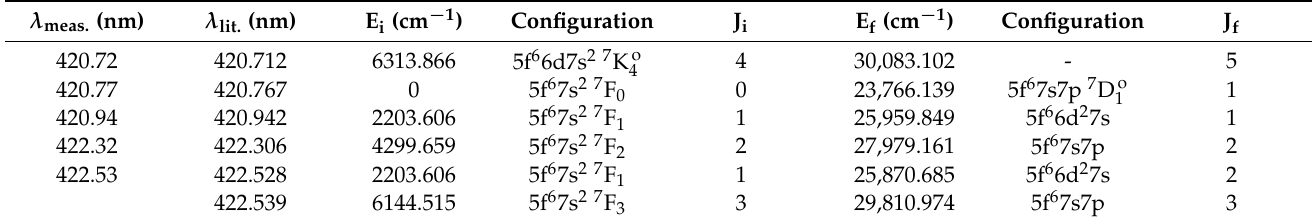
Table 1. List of the wavelengths λ meas of the detected peaks obtained from the grating-based Ti:Sapphire scan as presented in Figure 4. Assignments from the literature are also given [34,35], along with level energies and configurations. The reported wavelengths are in